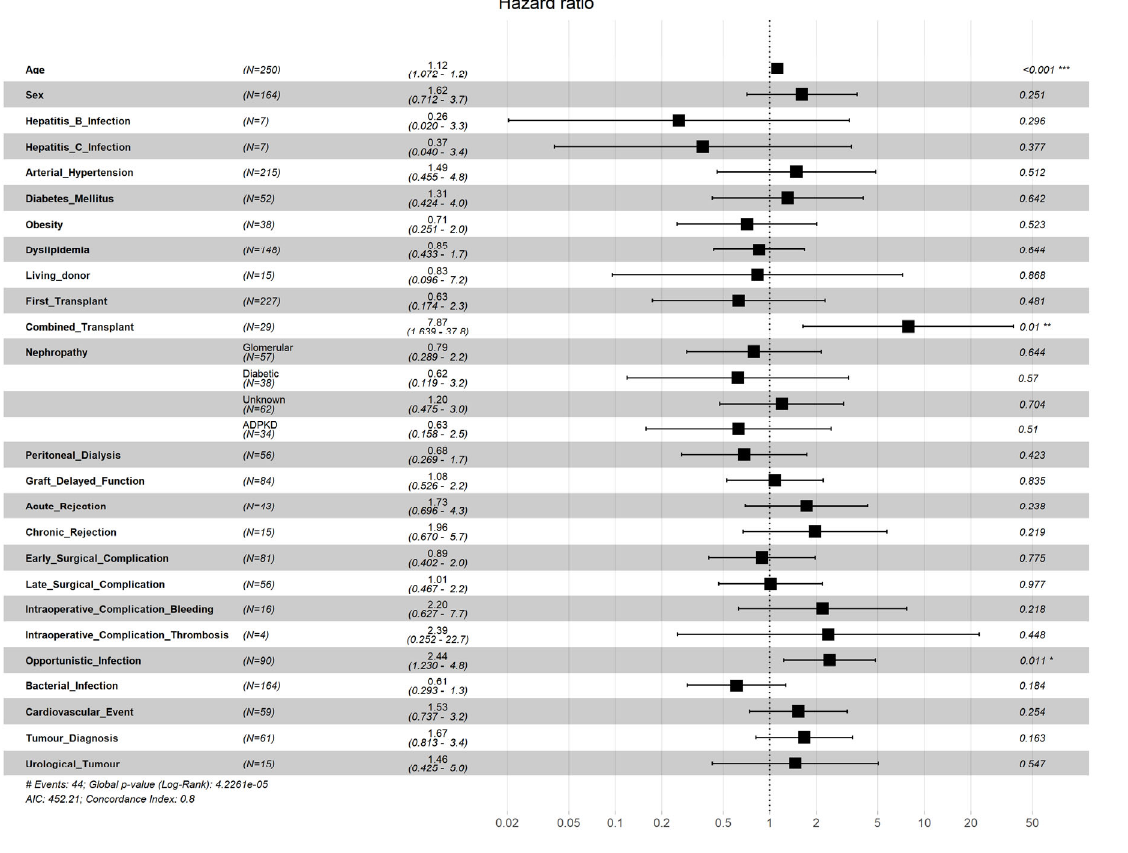
Figure 2. Results of the Cox proportional hazards model for overall survival, including the studied variables. * p -value < 0.05, ** p -value < 0.01, *** p -value < 0.001.